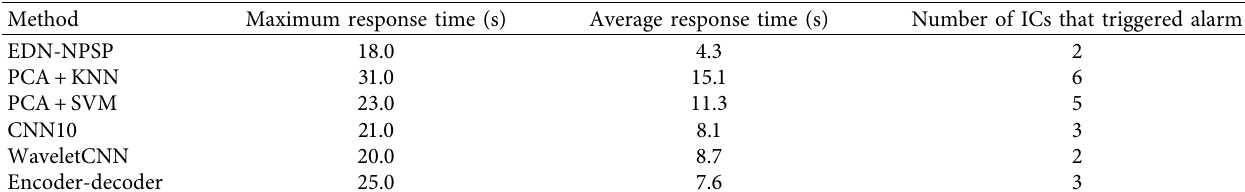
Table 5: Time performance of EDN-NPSP and other machine learning